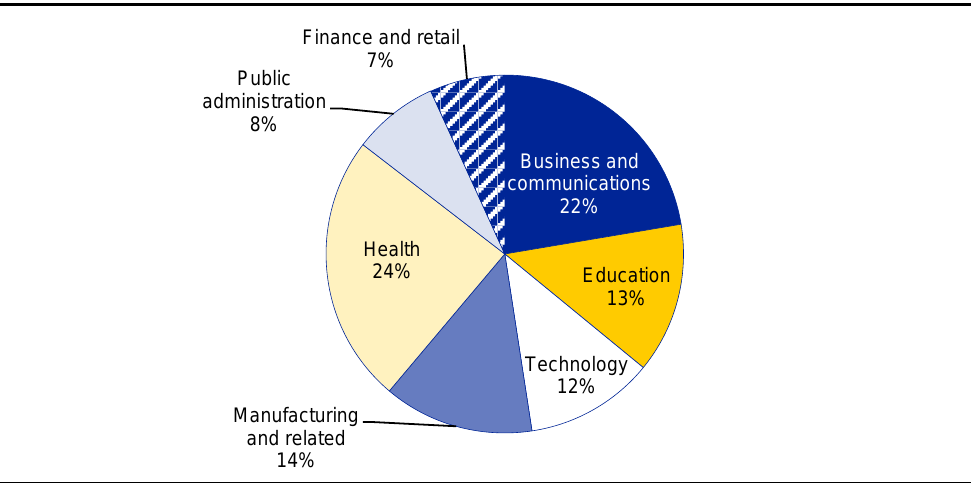
Figure 2. Percentage distribution of the organizations that responded to the survey, by